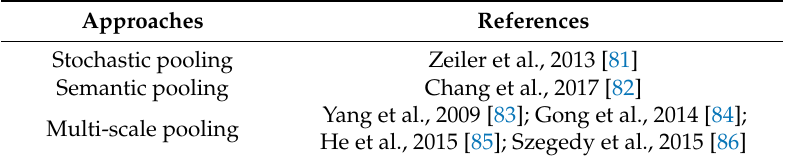
Table 4. Popular approaches and corresponding references for particular